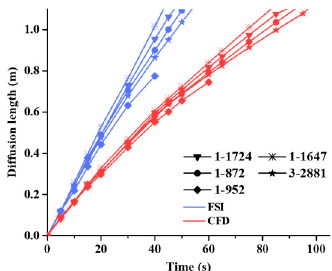
Figure 10. Variation of grouting diffusion length with time .